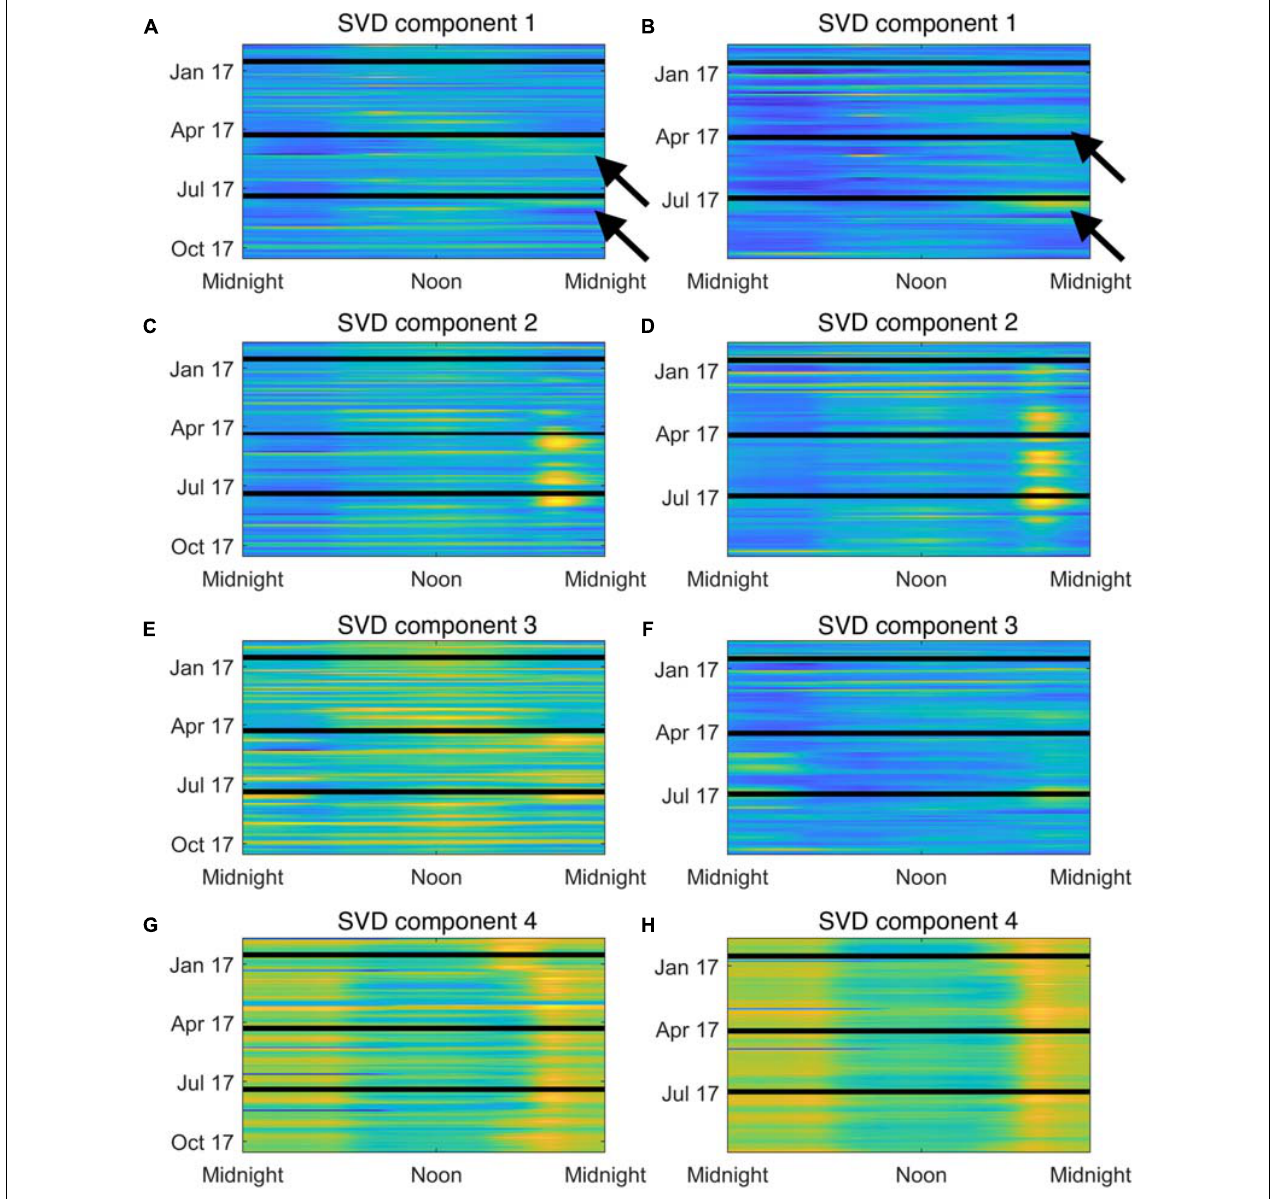
FIGURE 3 | Reconstructed time series from acoustic recordings at Site A (A,C,E,G) and Site B (B,D,F,H) using the first four SVD components. Time-of-day is indicated along the x -axis, and calendar day is along the y -axis. Color indicates standardized power spectral density, where cooler colors are quieter and warmer colors are louder. Black lines indicate breaks in deployments. (A,B) Show SVD component 1 that corresponds to the 60–130 Hz frequency bands (choruses are highlighted by arrows). (C,D) Show SVD component 2 that corresponds to the 300–500 Hz frequency band. (E,F) Show SVD component 3 that corresponds to the midshipman frequency band. (G,H) Show SVD component 4 that corresponds to the snapping shrimp frequency